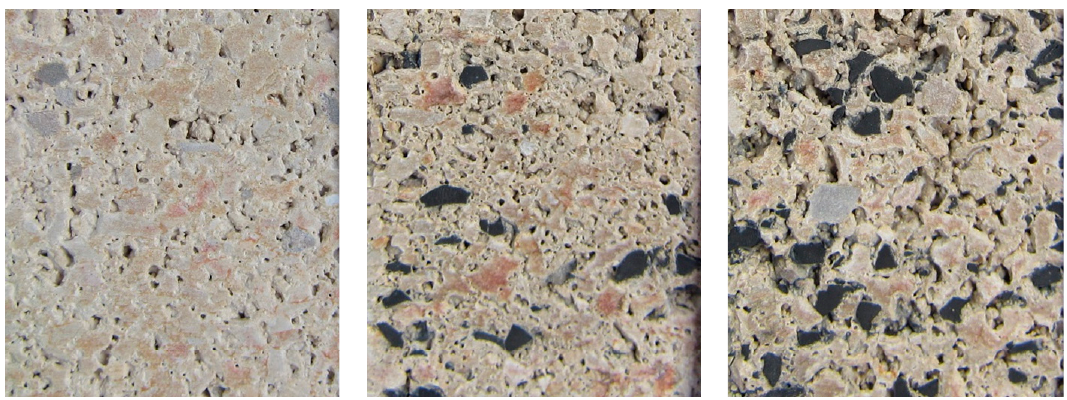
Figure 1. Mixtures: M1 ( left ); M2 ( centre ); M3 ( right ).